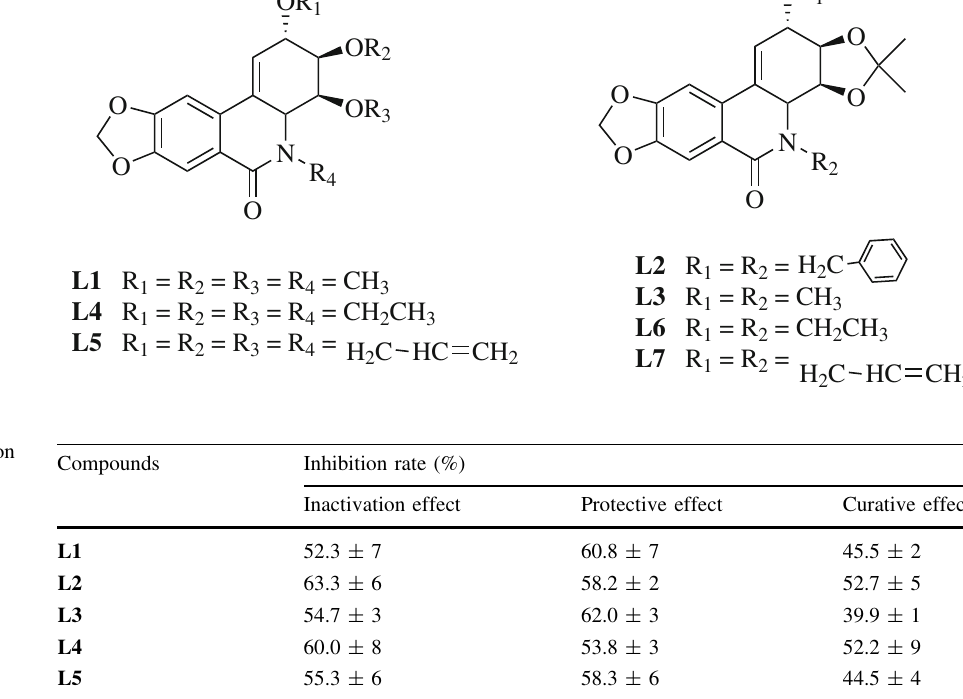
Fig. 2 Structures of lycoricidine